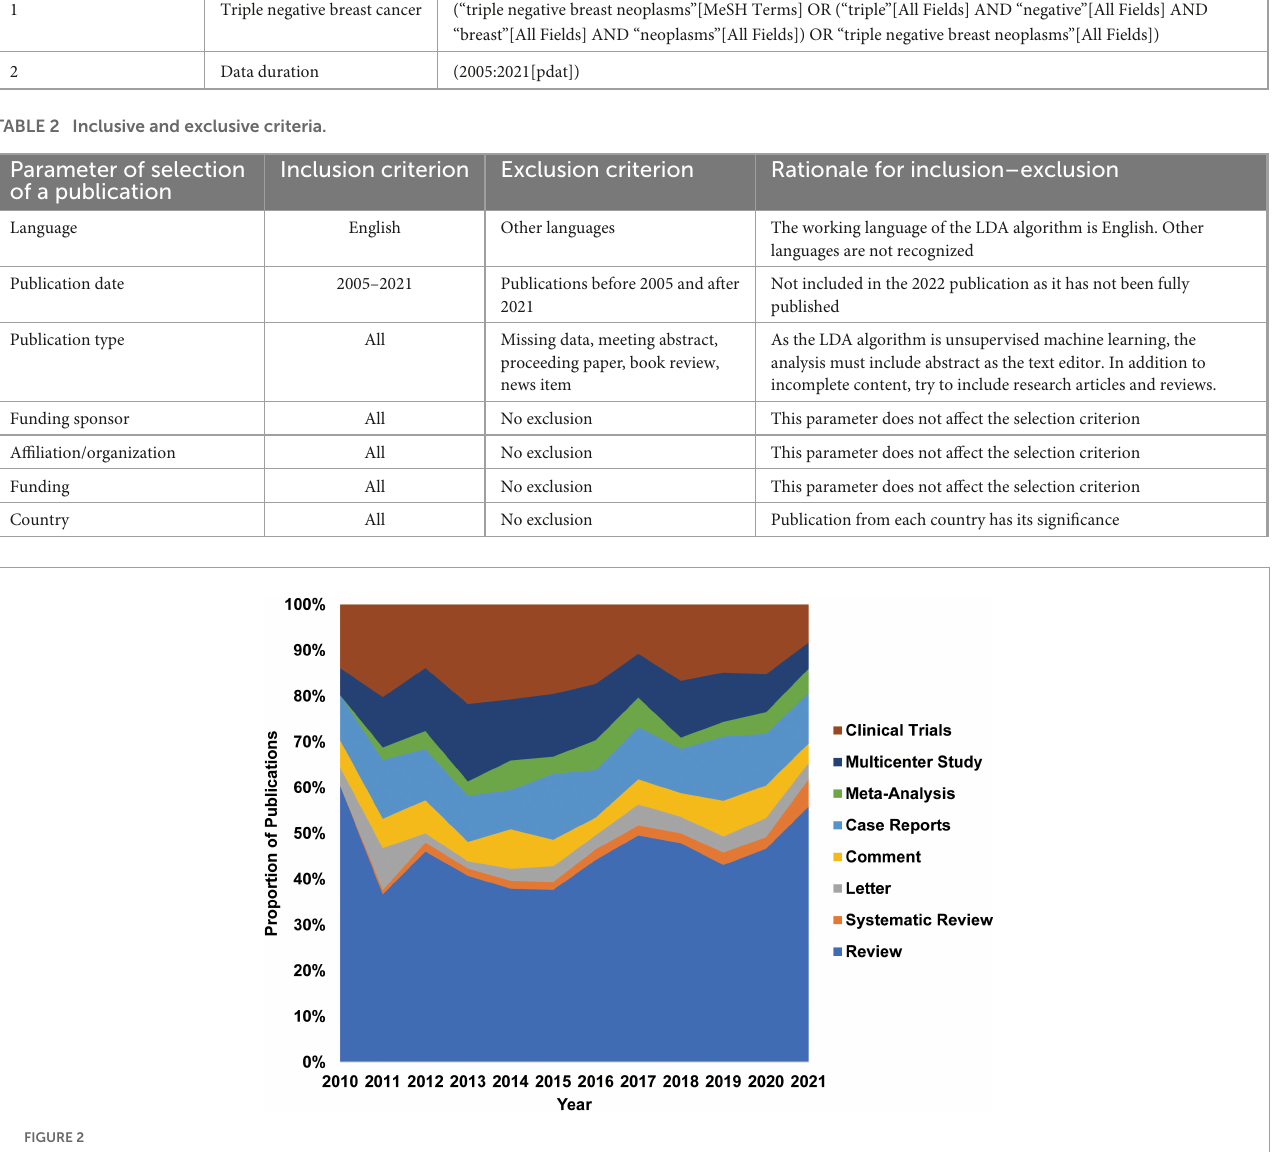
TABLE 1 Triple-negative breast cancer (TNBC) publications assortment steps.